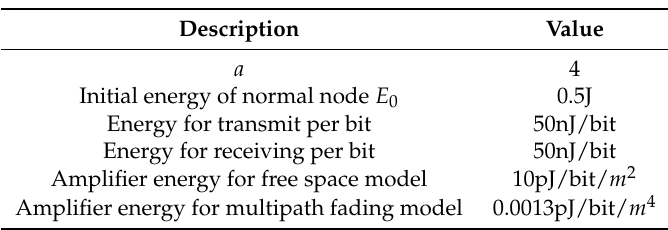
Table 2. Network energy consumption model.